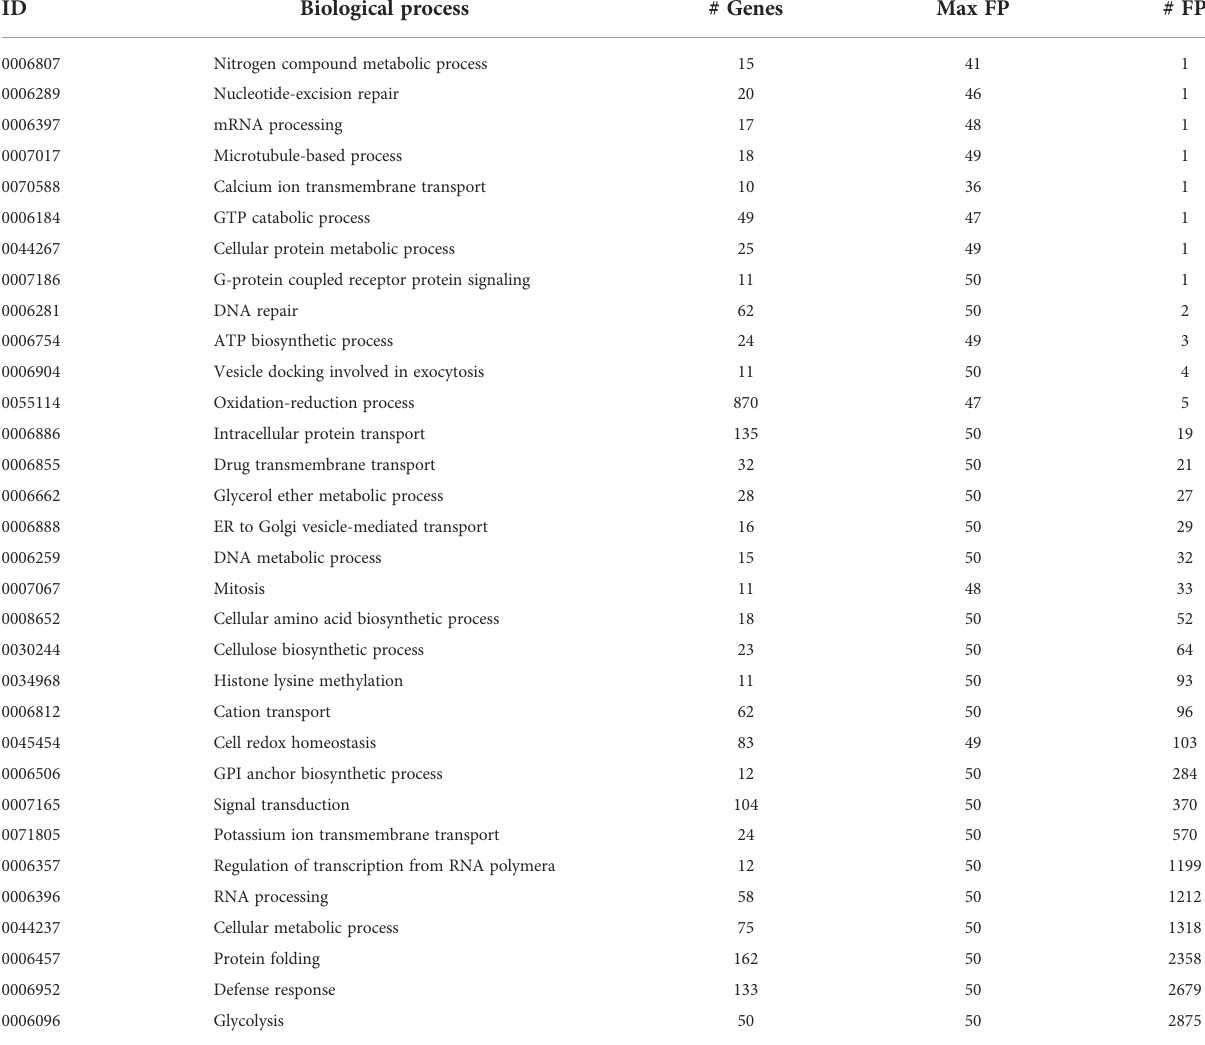
TABLE 1 Number of genes most frequently annotated as false positives for the 32 annotations by our model, trained from topological metrics extracted from an Oryza Sativa Japonica